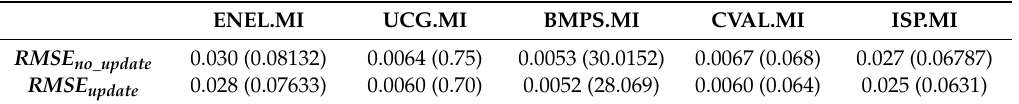
Table 1. ENEL.MI, UCG.MI, BMPS.MI, CVAL.MI, and ISP.MI RMSE normalized in [0, 1] while enclosed in bracket corresponding not normalized.